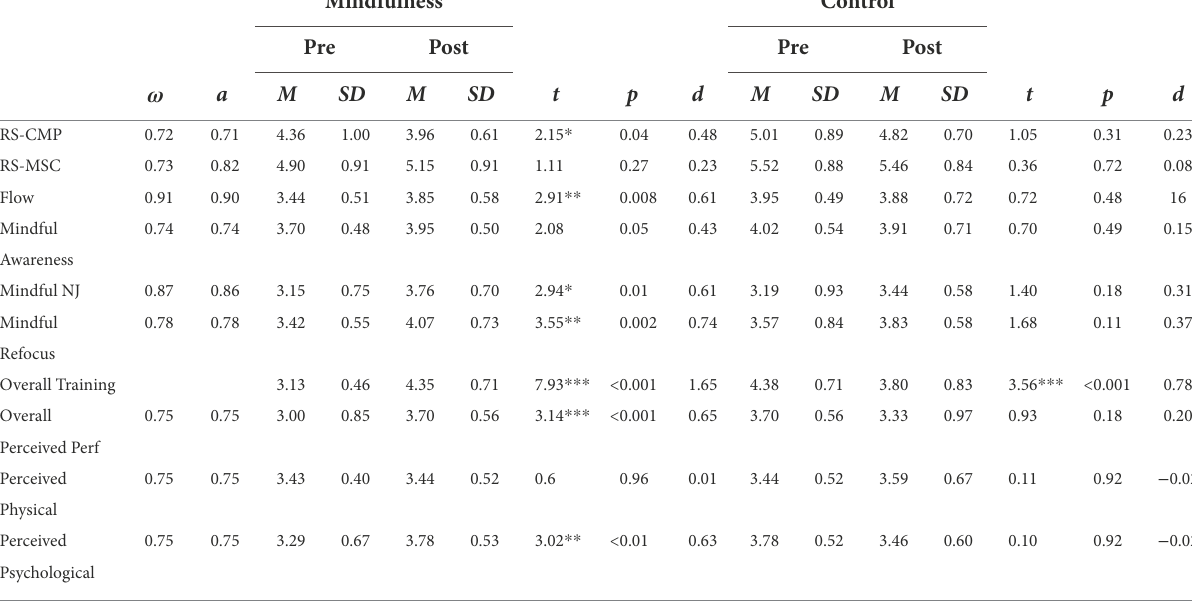
TABLE 2 Descriptive statistics and within group T-tests for differences from pre-to-post for dependent